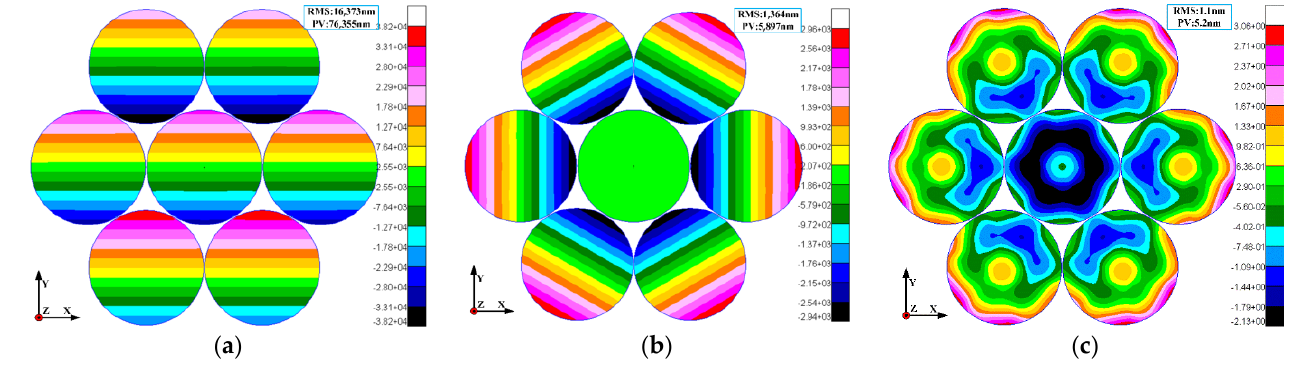
Figure 4. Mirror deformation under load, ( a ) Deformation of mirror surface in Y condition, ( b ) Deformation of mirror surface in Z condition, ( c ) Deformation of mirror surface in T